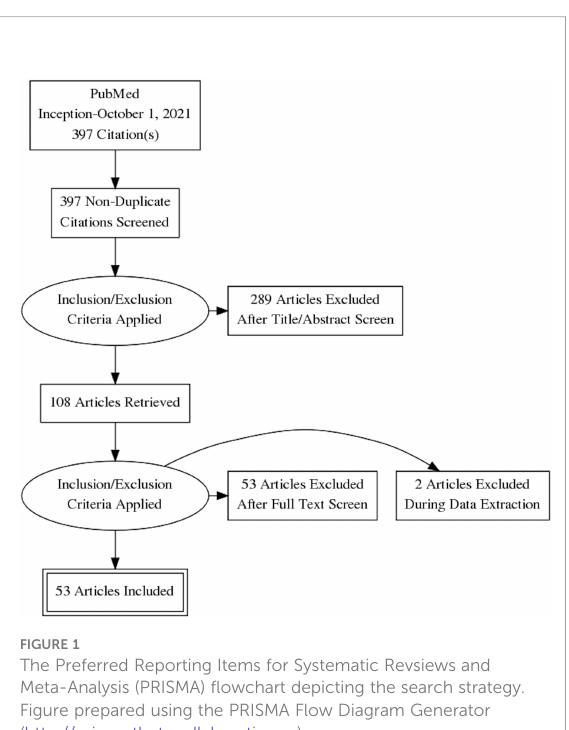
FIGURE 1 The Preferred Reporting Items for Systematic Revsiews and Meta-Analysis (PRISMA) fl owchart depicting the search strategy. Figure prepared using the PRISMA Flow Diagram Generator